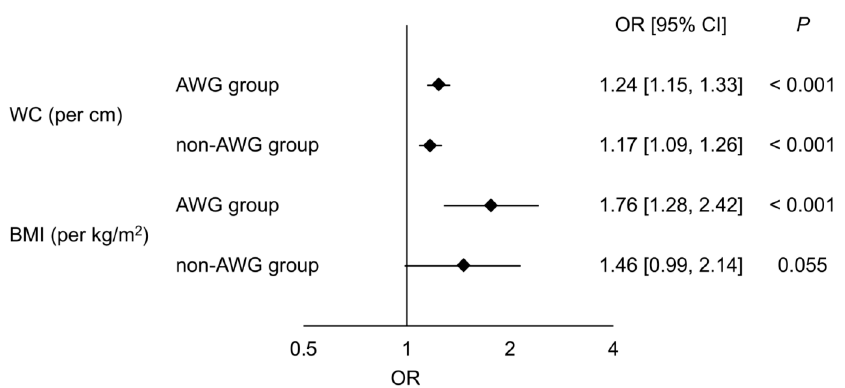
Figure 2. Associations between anthropometric parameters and NAFLD. Odds ratios with 95% confidence intervals for NAFLD evaluated by univariate analysis of waist circumference (per cm) and BMI (per kg / m 2 ) between the AWG and non-AWG groups after matching are shown. AWG, adult weight gain; BMI, body mass index; CI, confidence interval; OR, odds ratio; WC, waist circumference.